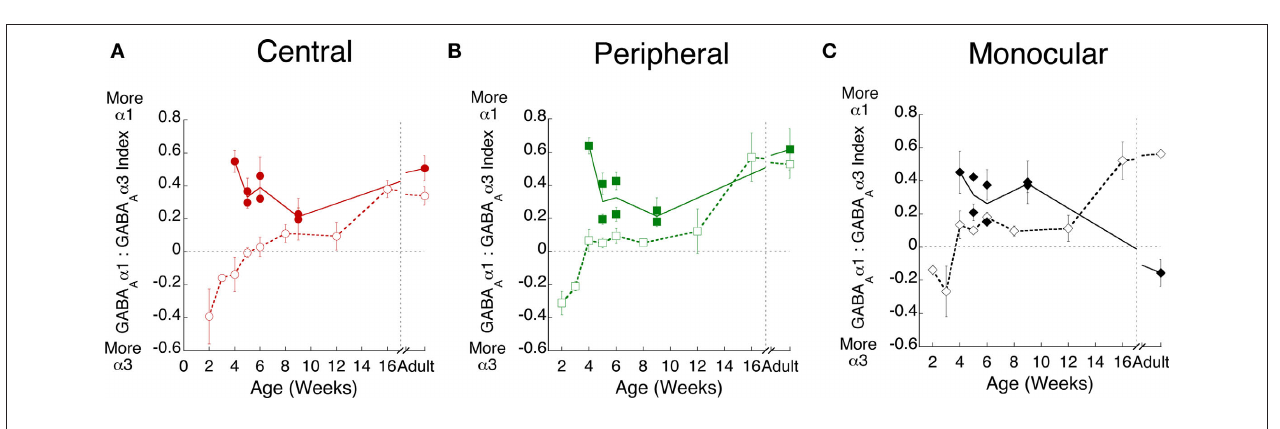
FiGure 6 | Monocular deprivation accelerates the switch to GABA Experience-dependent maturation of the GABA quantified in normal (open symbols, dashed lines) and monocularly deprived